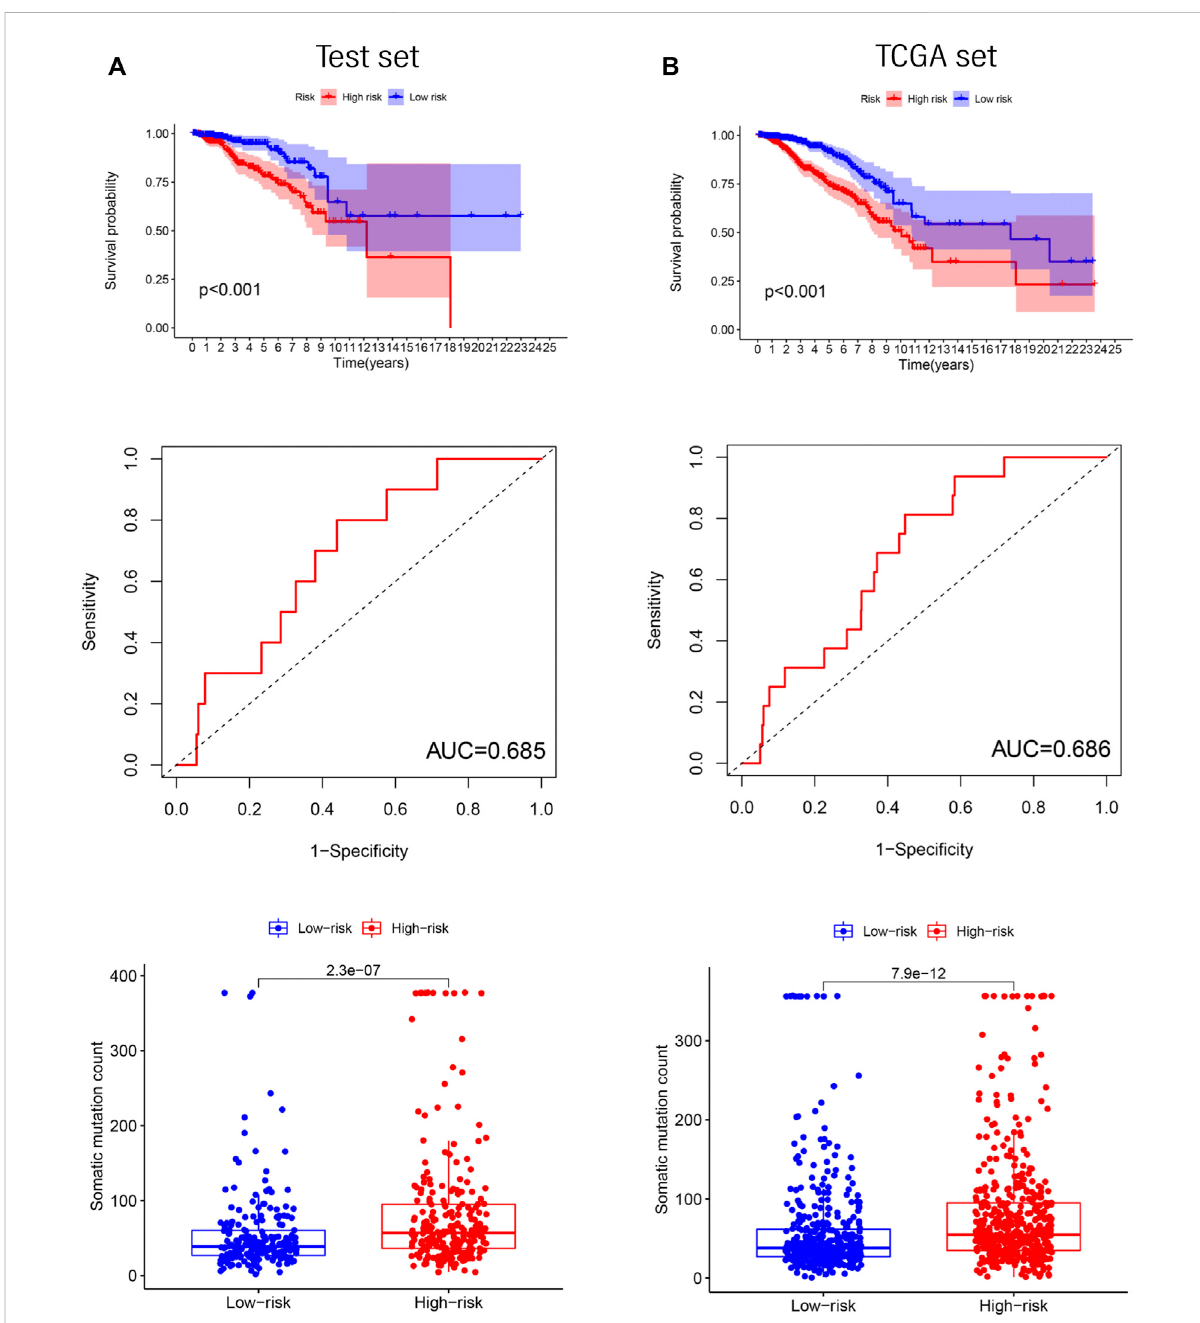
FIGURE 4 Veri fi cation of the GILncRNASig. (A) . The Kaplan – Meier curves and boxplot of somatic mutations between low- and high-risk, and the time- dependentROCcurveanalysisinthetestingset. (B) .TheKaplan – Meiercurvesandboxplotofsomaticmutationsbetweenlow-andhigh-riskgroups, and the time-dependent ROC curve analysis in TCGA